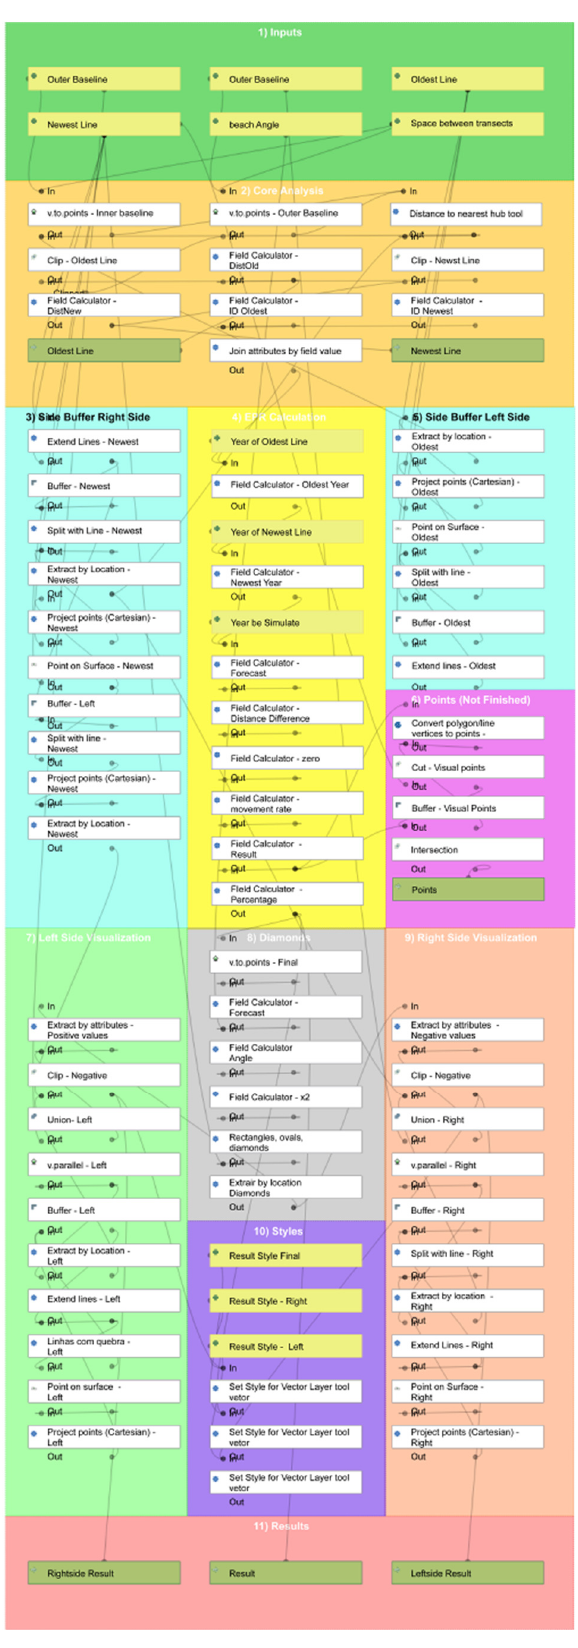
Figure 2. Graphical model of EPR4Q adapted for QGIS 3.14 since the original EPR4Q was created in QGIS 3.4. Transect creation section: dark green (1) are the inputs (shorelines and baselines); orange (2) is the transects creation process; calculation section: yellow (4) the application of the end point